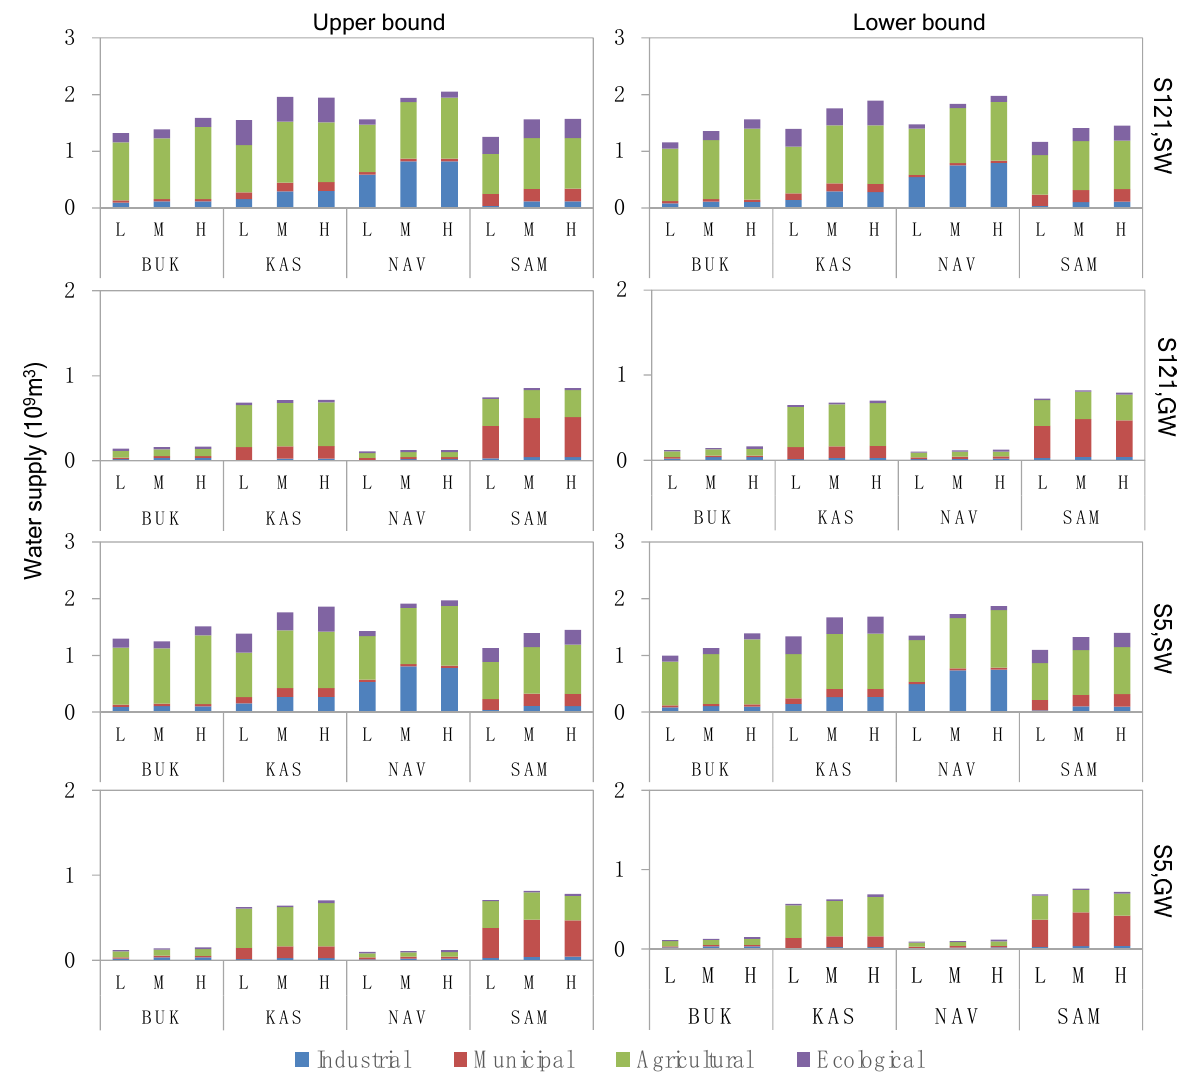
Figure 6. The water-supply schemes for water users in different scenarios.